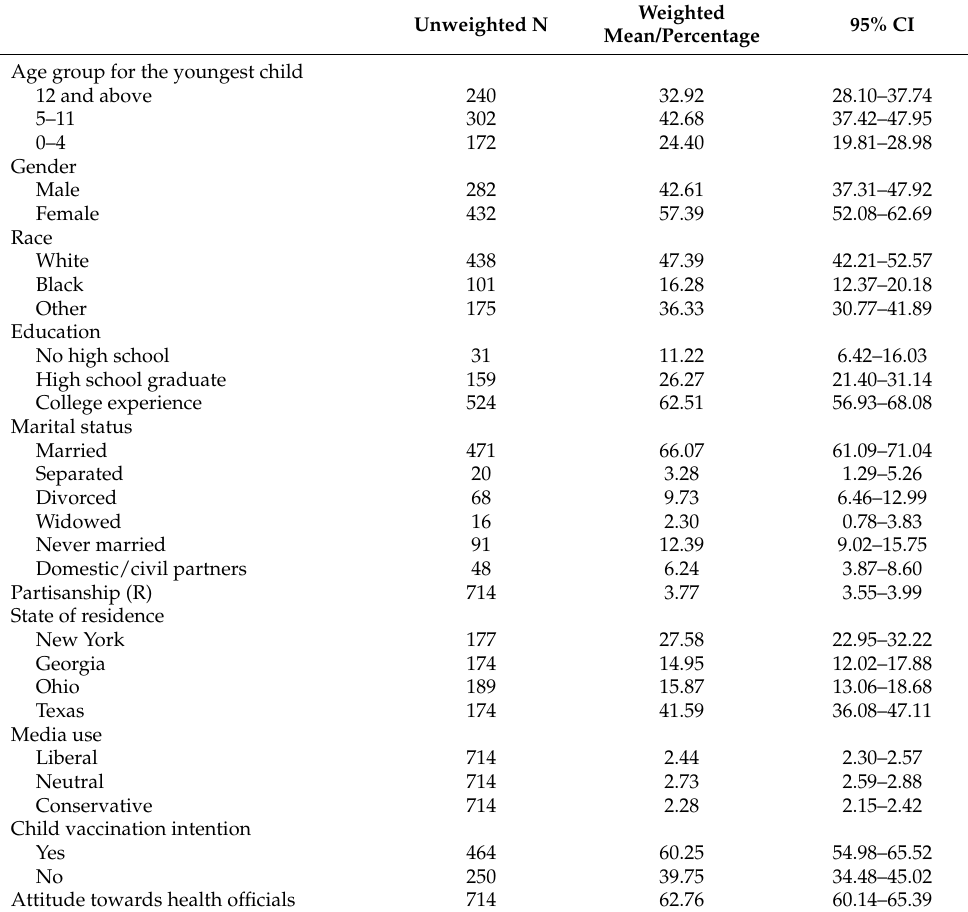
Table 1. Descriptive information about the sample (N =